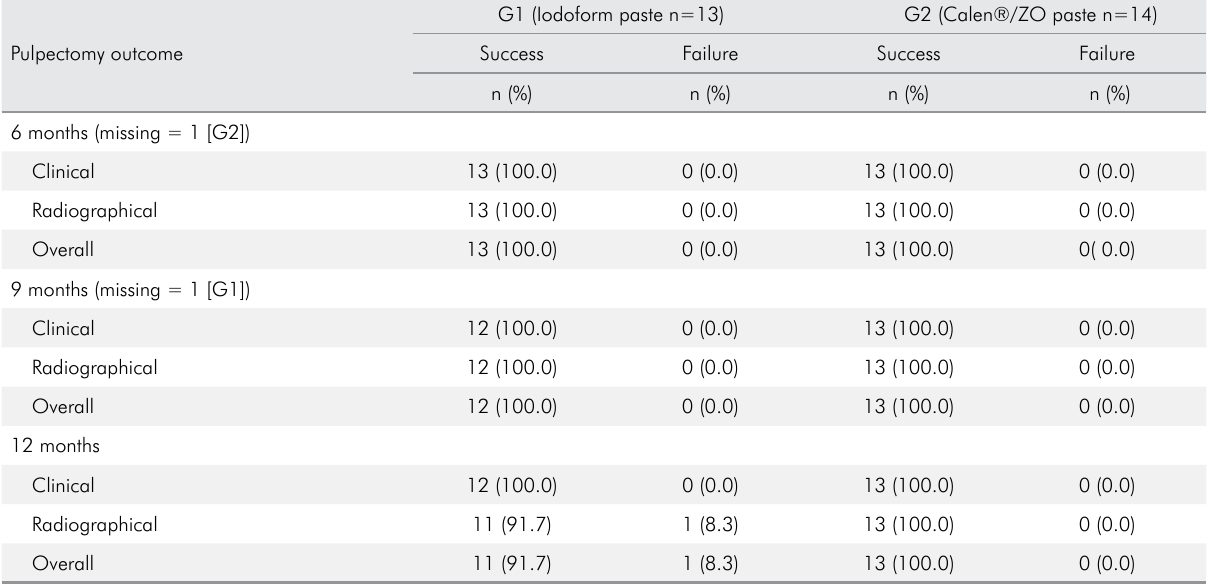
Table 2. Clinical, radiographical, and overall pulpectomy outcome at 6, 9, and 12 months compared by groups.